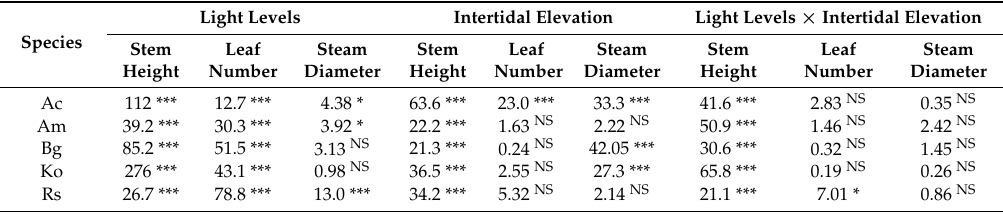
Table 2. F values of two-way ANOVA tests indicating the differences in morphological parameters in varying light levels and intertidal elevation among different mangrove species.